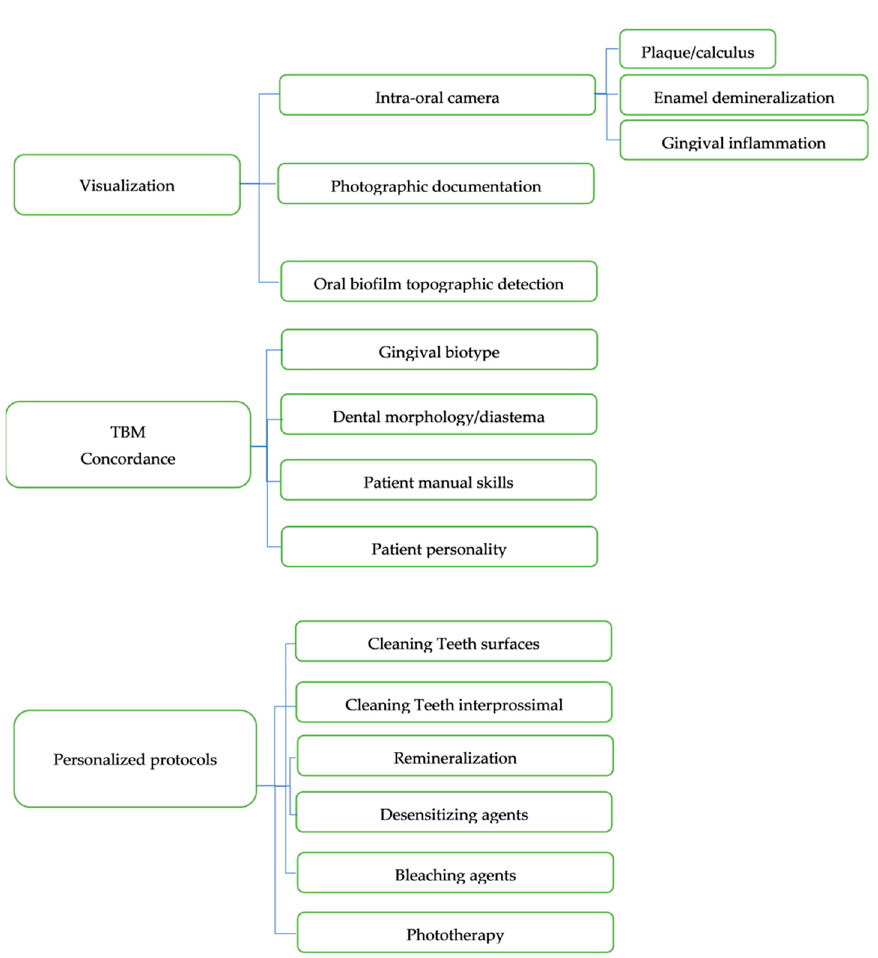
Figure 2. Flowchart with decision tree on personalized protocols in patients with facial/dental trauma based on TBM.